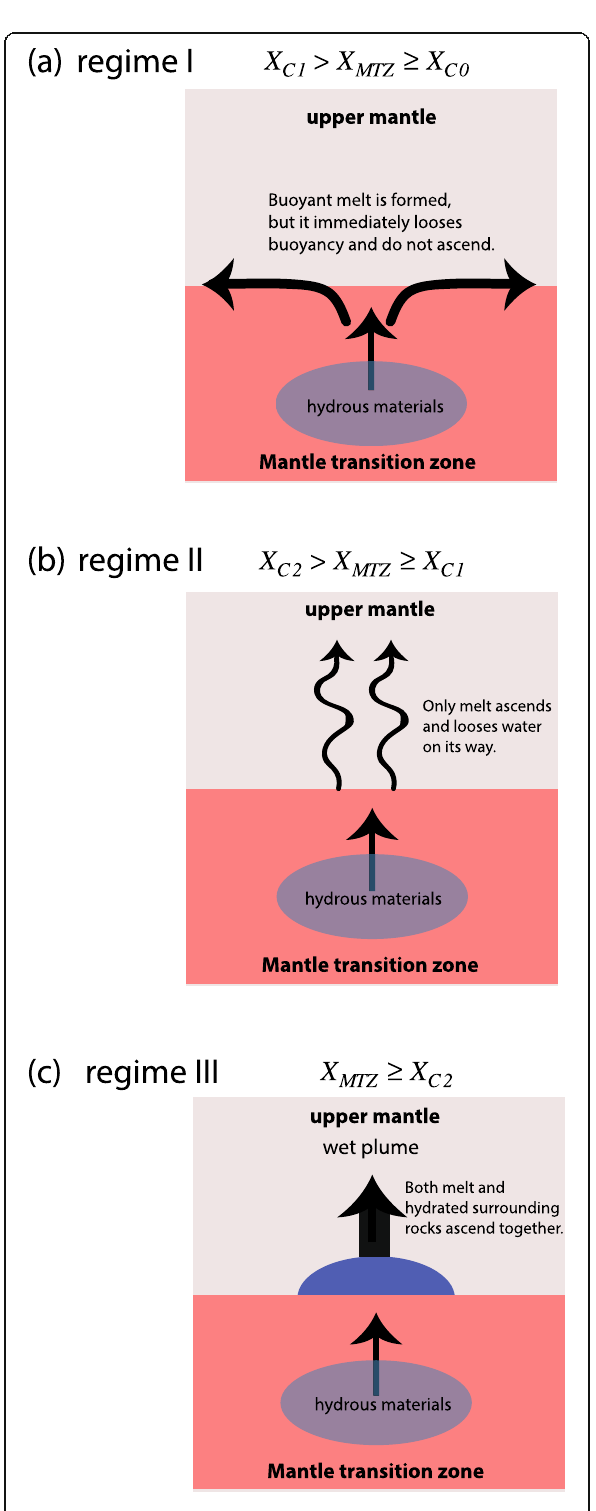
Fig. 11 Cartoons showing how water is transported across the cool regions of 410 km ( S C in Fig. 9). In a cool region, when water-rich buoyant materials ( X MTZ ≥ X C 0 ) move up to ~ 410 km, a buoyant melt is formed. a R egime I: If X MTZ is small ( X C 1 > X MTZ ≥ X C 0 ), water in the melt is removed to surrounding minerals immediately and melt does not ascend. b R egime II: When X MTZ exceeds a critical value ( X MTZ ≥ X C 1 ), melt does not lose its buoyancy immediately. However, if X MTZ is not very high ( X C 2 > X MTZ ≥ X C 1 ( X C 1 ~0.2%, X C 2 ~1%)), then surrounding minerals remain dry and heavy, and only melt ascend (regime II). In this case, ascending melt will lose most water to the surroundings, and not much water is transported to the shallow region. c Regime III: When X MTZ is high ( X MTZ ≥ X C 2 (~ 1%)), then wet melt hydrates surrounding minerals extensively, and melt and minerals together become buoyant. They ascend together to transport water to the shallow regions. Wet materials migrate up in the MTZ as well, but the velocity of transportation of wet materials is much faster in the upper mantle than in the MTZ due to the difference in solid viscosity between these